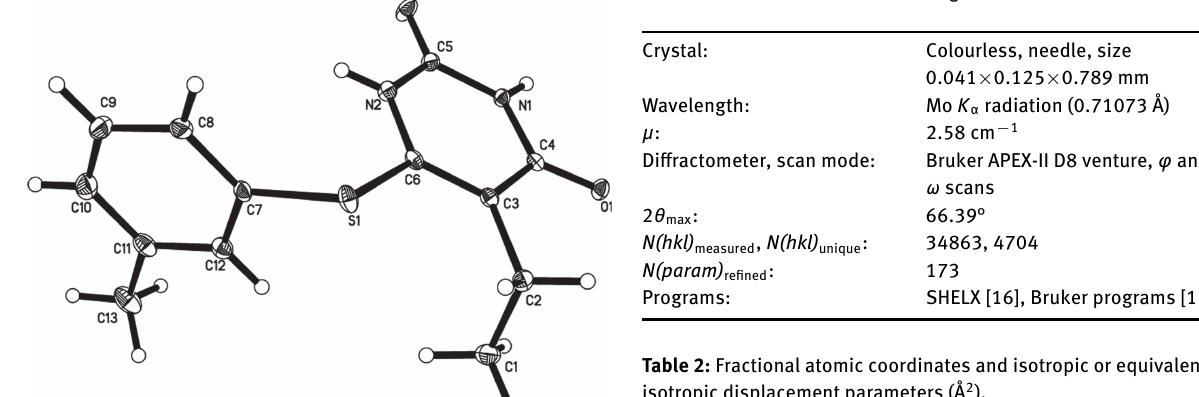
Table 1: Data collection and handling.